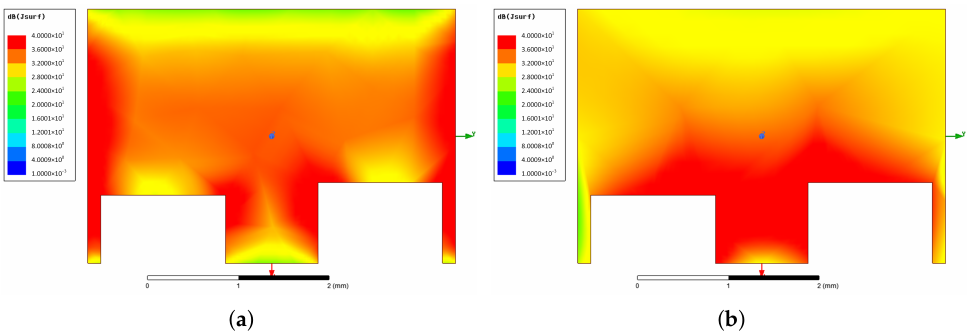
Figure 11. Surface current distribution plot of the aperture-coupled E-shaped antenna at ( a ) 26.4 GHz and ( b ) 38.5 GHz (color scale in